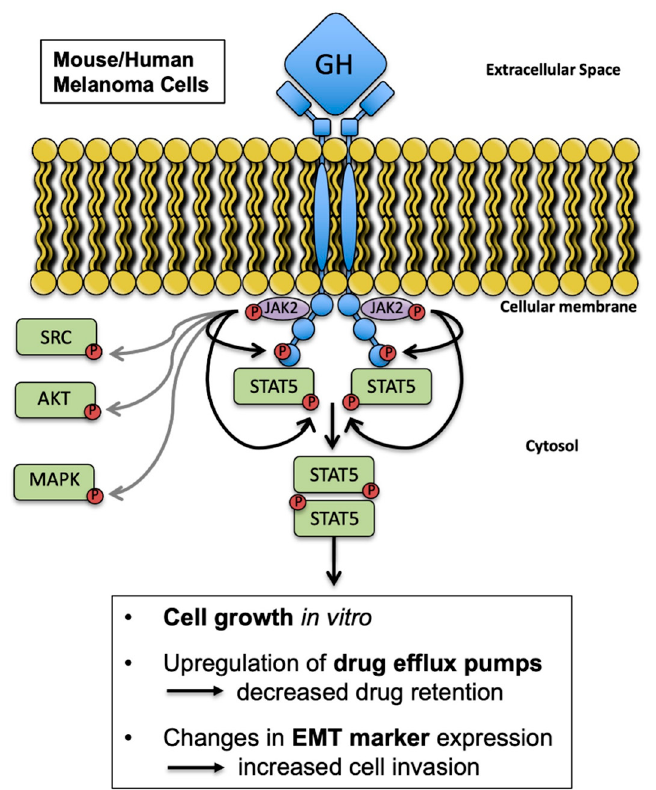
Figure 5. Proposed model for this study. GH stimulates melanoma growth in vitro through GHR activation independent of IGF-1. In the syngeneic mouse melanoma models, elevated GH, independent of IGF-1, alters tumor expression of multidrug e ffl ux pumps and epithelial-mesenchymal transition markers in vivo.